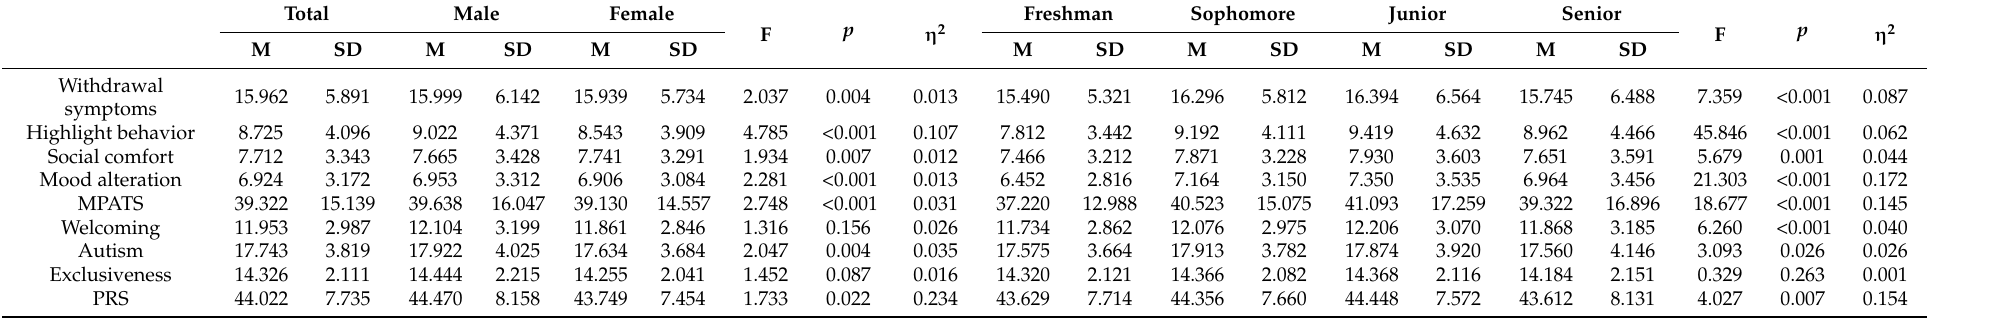
Table 3. Current status of MPA and peer relationships among university